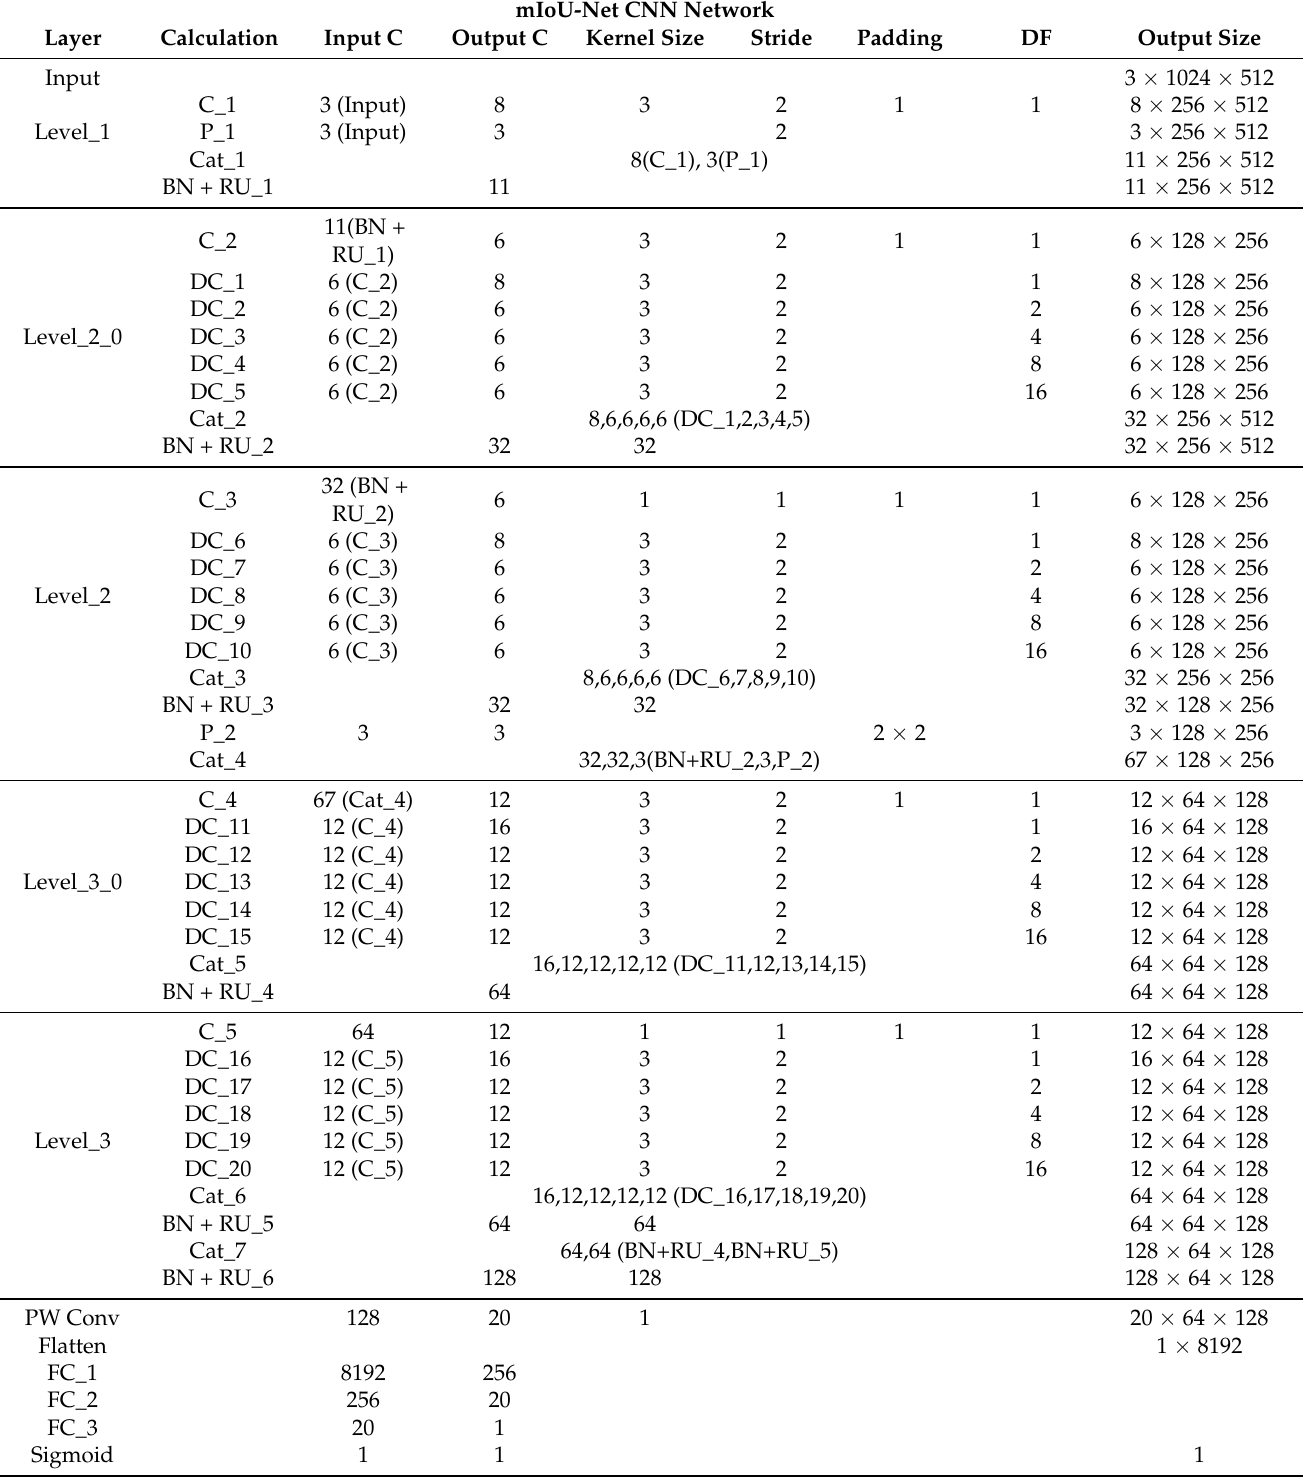
Table 3. mIoUNet architecture